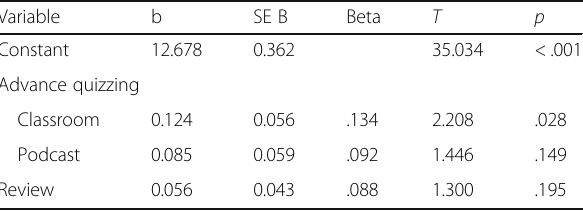
Table 5 Regression analysis predicting “ Introduction to Perception ” exam performance from advance quizzing and review of “ introduction to memory ” in first-year students Variable